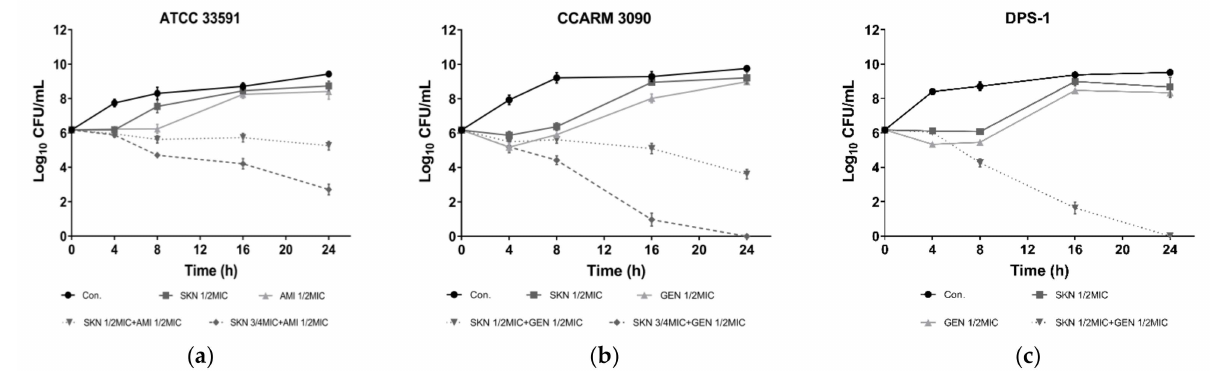
Figure 2. Time-kill curves of SKN and antibiotics alone and in combination against ATCC 33591 ( a ), CCARM 3090 ( b ) and DPS-1 ( c ). The data are means ± SD of triplicate determinations.